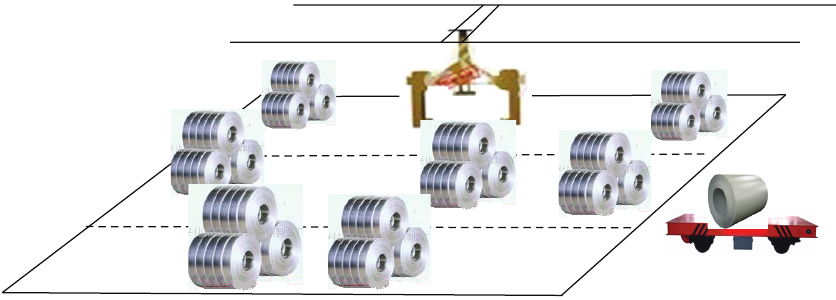
Figure 1: Coil storage in an area of steel coil